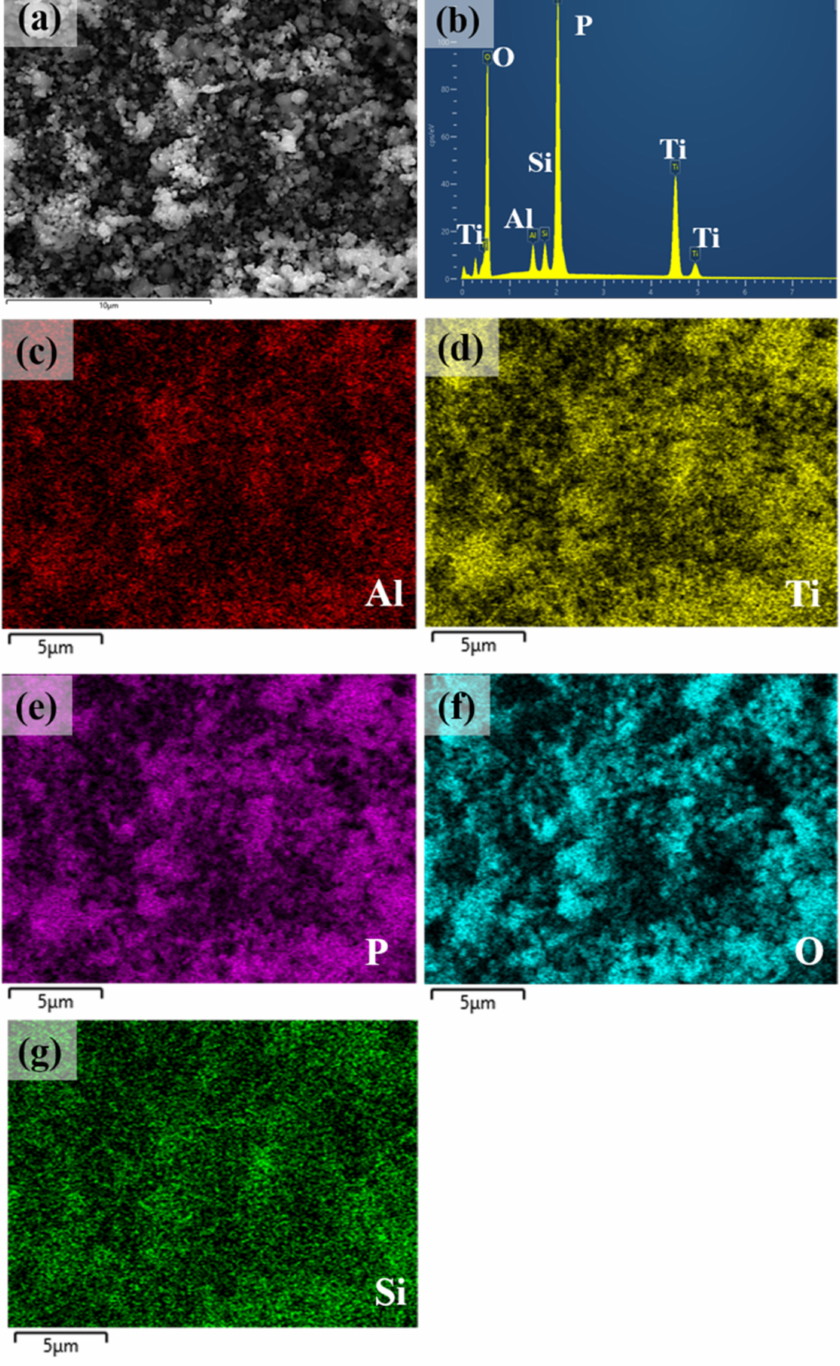
Figure 3. ( a ) SEM image of LASTP-X powder, ( b ) EDS spectra of the powder, and EDS elemental mapping of ( c ) Al, ( d ) Ti, ( e ) P, ( f ) O, and ( g ) Si